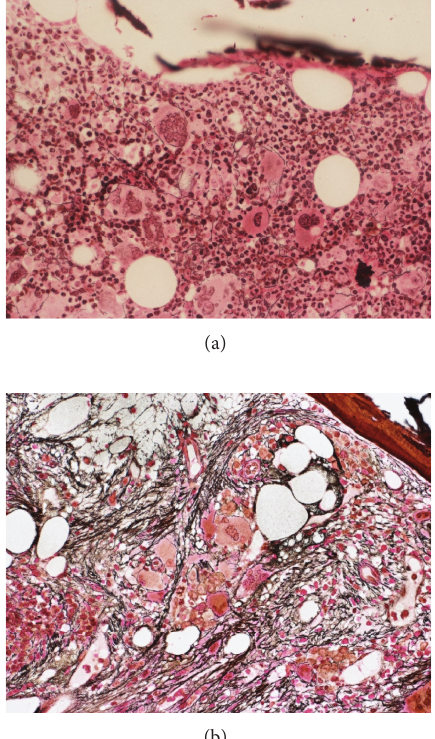
Figure 2: (a) demonstrates the patient’s bone marrow reticulin stain at initial presentation demonstrating only fine reticulin deposition around megakaryocytes. (b) is bone marrow biopsy 10 years after diagnosis demonstrating grade 3 reticulin